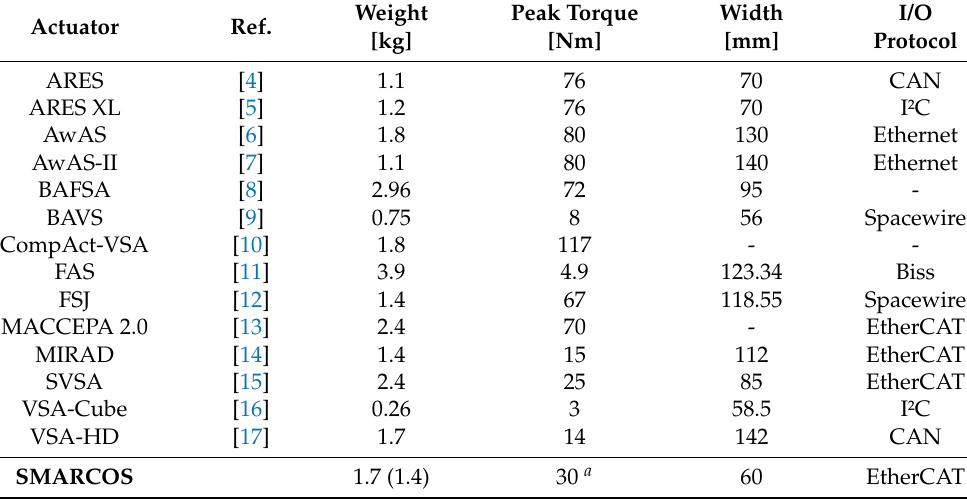
Table 4. Comparison between the specifications of SMARCOS and state-of-the-art